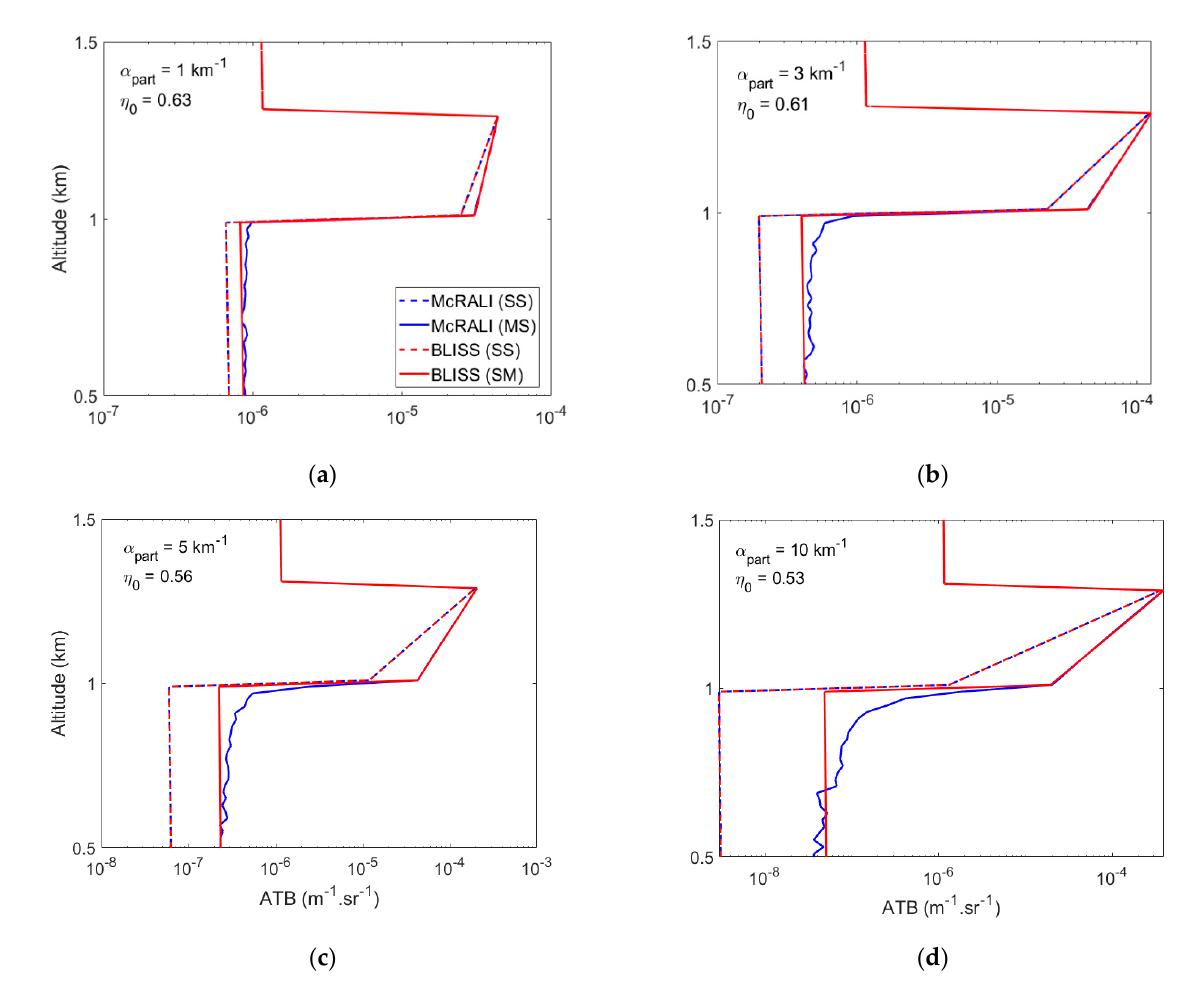
Figure 4. Vertical profiles of ATB computed by BLISS (red curves) and McRALI (blue curves) for stratocumulus clouds with R ef f = 9 µ m in single (dotted curves) and multiple (full curves) scattering regimes. Stratocumulus extinction α part and BLISS multiple-scattering coefficient η 0 are ( a ) 1 km − 1 and 0.63, ( b ) 3 km − 1 and 0.61, ( c ) 5 km − 1 and 0.56, and ( d ) 10 km − 1 and 0.53.